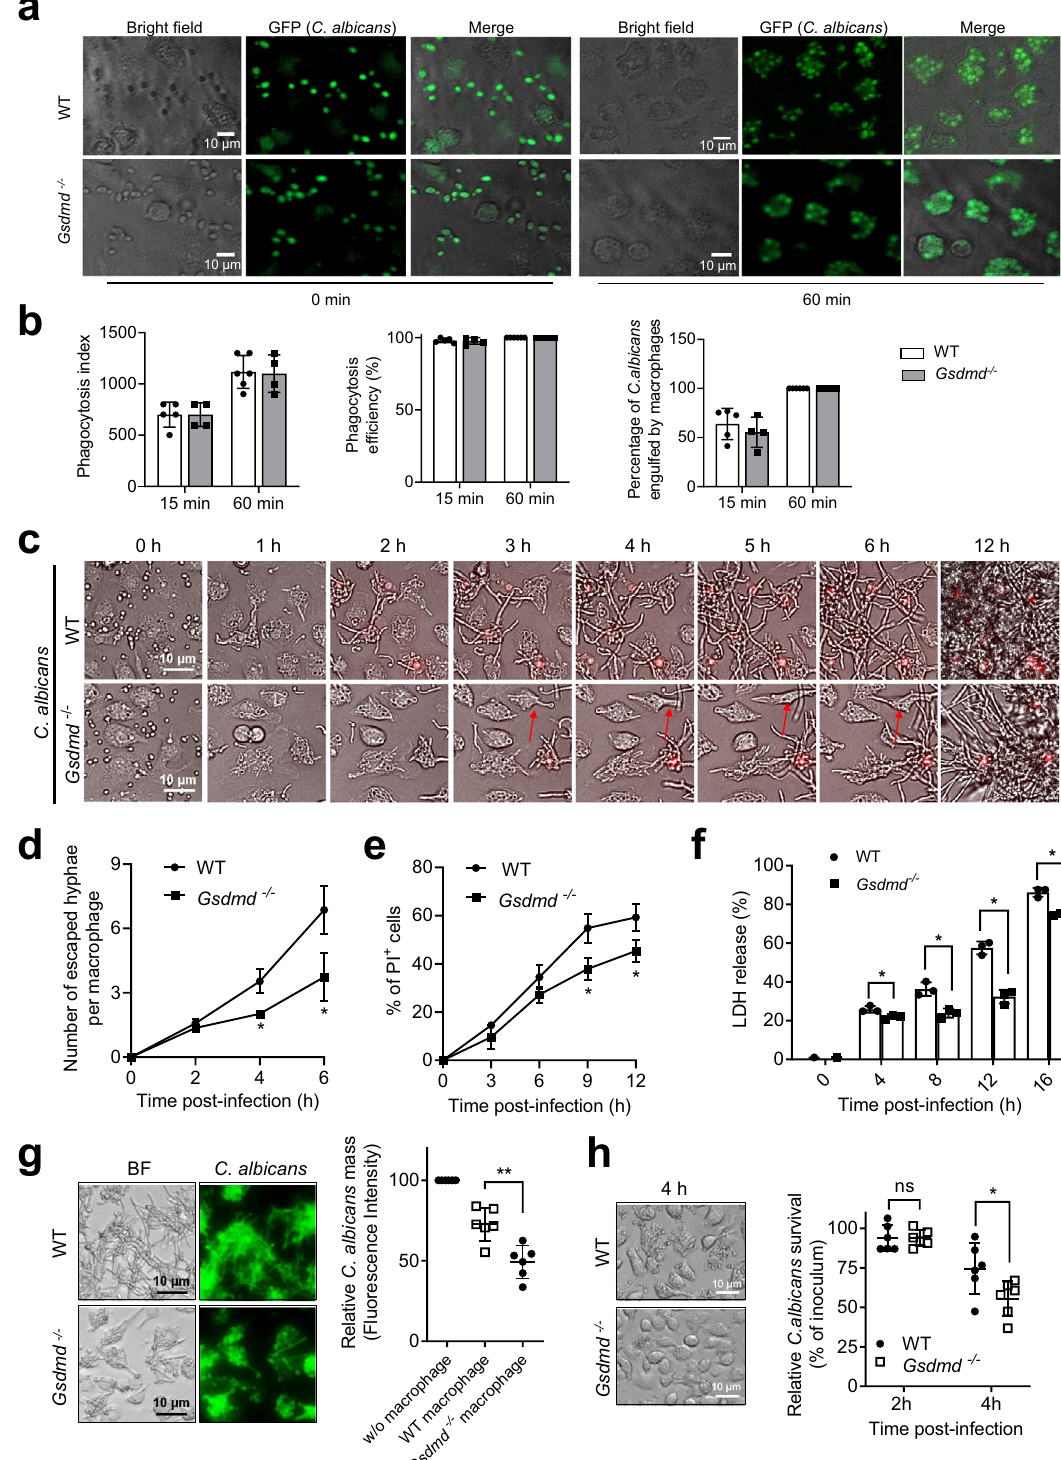
(>50%) than treatment with WT C. albicans (Fig. 5a, b). Similarly, IL-1 β release was signi fi cantly reduced when macrophages were treated with candidalysin-de fi cient C. albicans . However, candi- dalysin disruption in C. albicans did not completely abolish IL-1 β release from BMDMs, indicating the presence of candidalysin- independent IL-1 β production (Fig. 5c). IL-1 β release induced by candidalysin-de fi cient C. albicans was signi fi cantly inhibited in NATURE COMMUNICATIONS| (2021) 12:6699